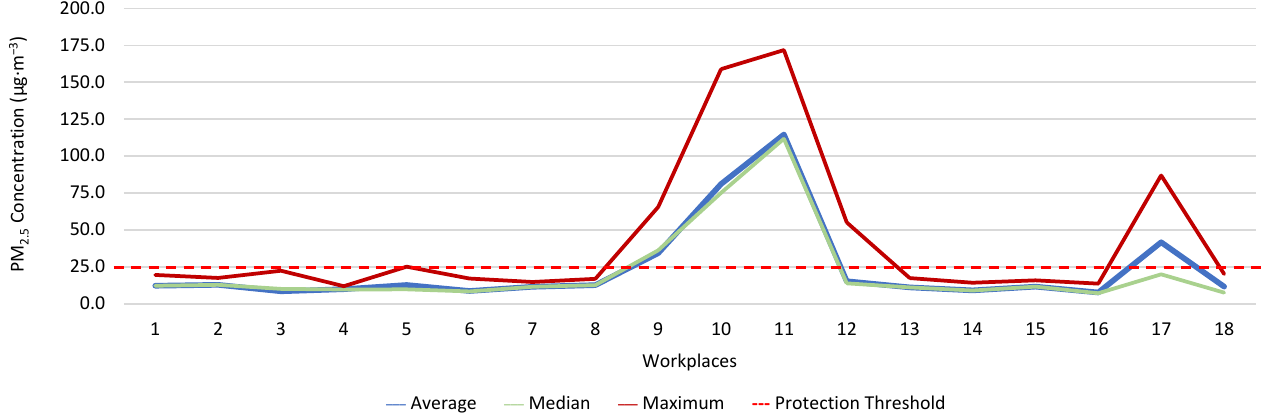
Figure 14. CH 2 O concentration (ppm) inside workplaces.